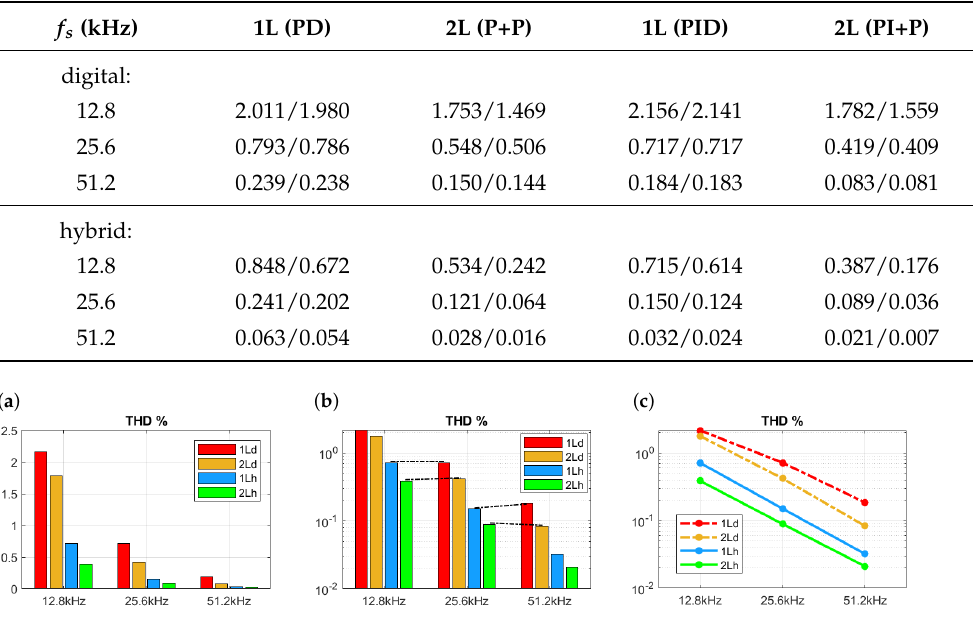
Figure 20. THD values for different structures with controllers PI/PID and carrier frequencies f s . ( a ) THD in linear scale, ( b , c ) in logaritmic scale.